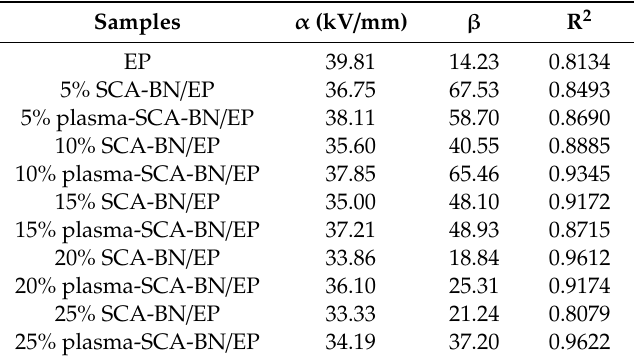
Figure 12. Weibull plots of the breakdown strength of epoxy resin (EP) and BN / EP nanocomposites with SCA treated BNNSs (SCA-BN / EP) and plasma and SCA treated BNNSs (plasma-SCA-BN / EP) at different contents (5%, 10%, 15%, 20%, 25%). Table 2. Parameters of the Weibull analysis.